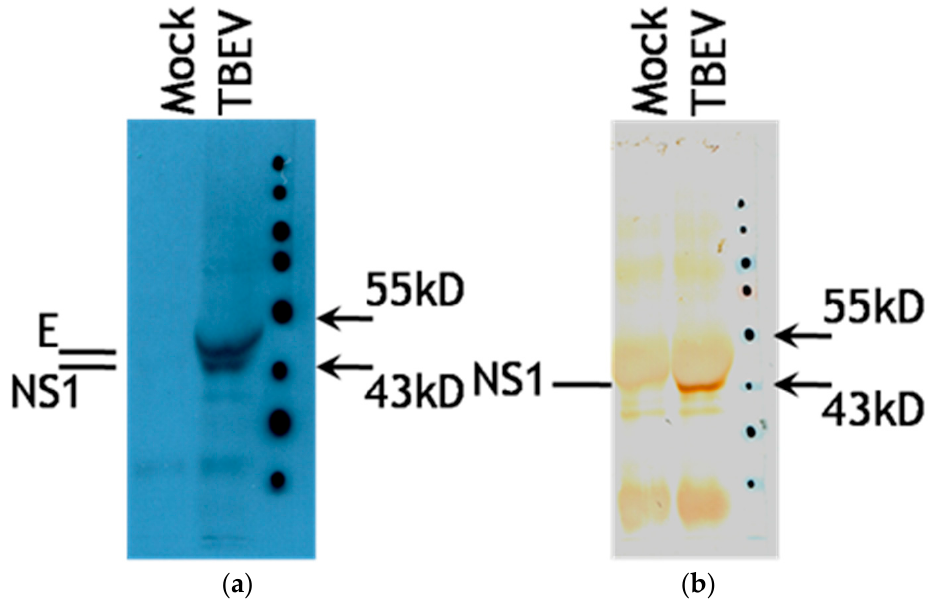
Figure 2. ( a ) TBEV ‐ infected PEK cell culture lysate (TBEV) and lysate of intact cells (Mock) labeled with 14 C ‐ chlorella hydrolysate were immunoprecipitated with the patient’s CSF on protein A ‐ Se ‐ pharose, examined by SDS ‐ PAGE, and developed on X ‐ ray film. E and NS1 bands show the pres ‐ ence of antibodies to these proteins in the CSF. ( b ) Western blot of the obtained immunoprecipitate stained with a polyclonal rabbit serum to NS1 protein of TBEV.